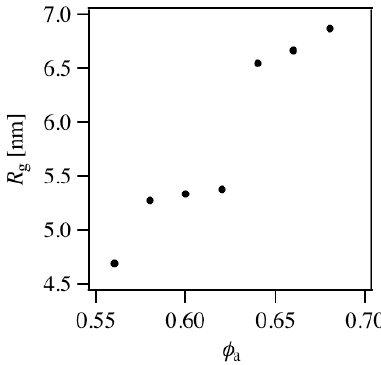
Figure 9. The radius R g of gyration of the aggregated domain as a function of φ a .